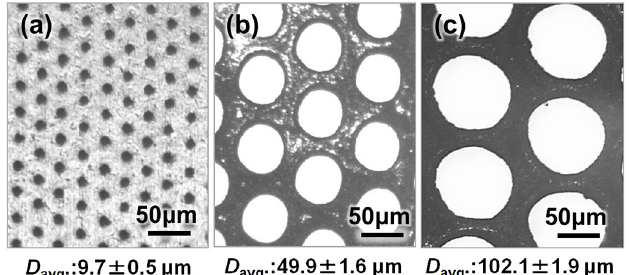
Fig. 2. Optical microscopic images of picosecond laser processed metallic masks with diameters D of 10 m m (a), 50 m m (b) and 100 m m (c) and a constant interspace distance linter l inter of 30 m m. * D avg :